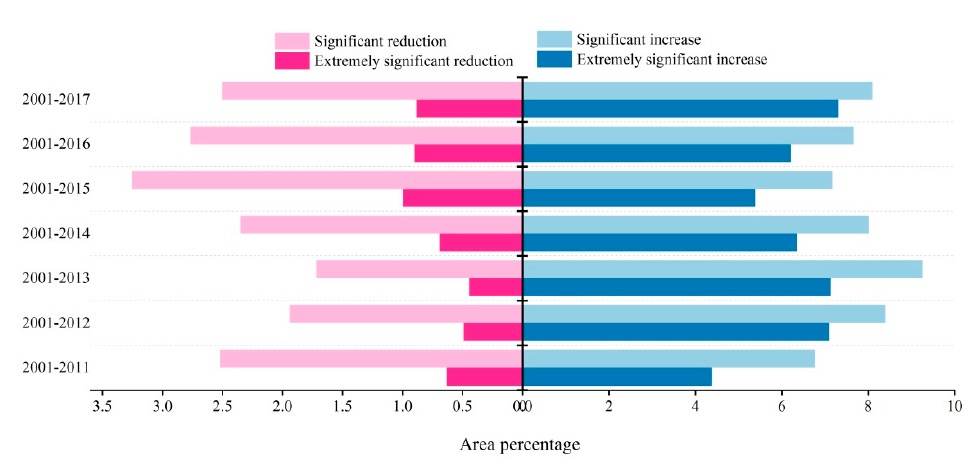
Figure 6. The proportion (%) of different NDVI variation trend in seven time periods.